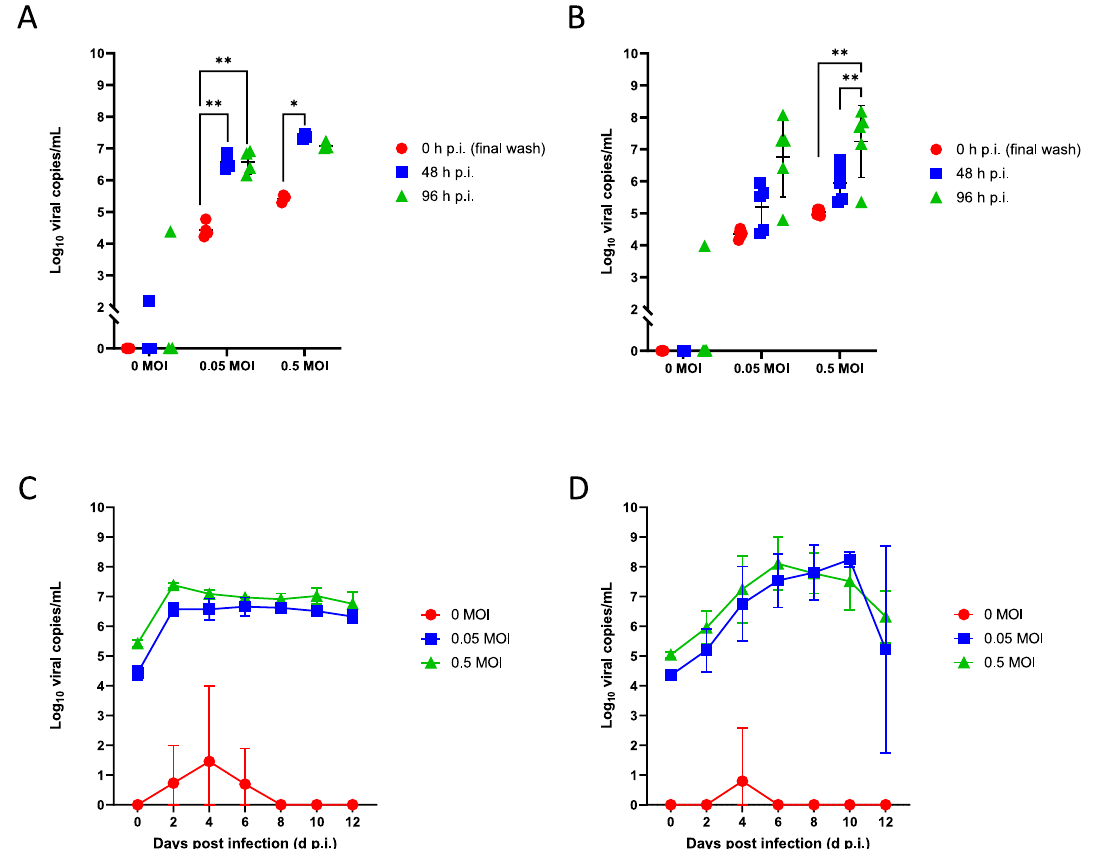
Figure 9. Infection of coronavirus strains in PREDICT96-ALI model. RT-qPCR analyses for viral copies of HCoV-NL63 ( A , C ) and HCoV-OC43 ( B , D ) in the apical wash of PREDICT96-ALI airway tissue model from a single donor, measured over 12 days across three different MOIs (0, 0.05, 0.5). ( A ) PREDICT96-ALI airway tissue inoculated with HCoV-NL63 and monitored for an increase in viral load at 48 h intervals with a statistically significant increase in viral copies at 48 and 96 h p.i. compared to 0 h p.i. for the MOI 0.05 condition, as well as a statistically significant increase at 48 h p.i. compared to 0 h p.i. for the MOI 0.5 condition. ( B ) PREDICT96-ALI airway tissue inoculated with HCoV-OC43 and monitored for an increase in viral load at 48 h intervals with a statistically significant increase in viral copies at 48 and 96 h p.i. compared to 0 h p.i. for the MOI 0.5 condition. Statistical significance: *p ≤ 0.05 and **p ≤ 0.01. N = 4–5 tissue replicates per donor, time-point and condition. Replicates that did not meet the minimum signal intensity after 45 PCR cycles are displayed along the x-axis. Viral copy number versus day post-infection shown for HCoV-NL63 ( C ) and HCoV-OC43 ( D ) shown for each MOI as indicated in the legends. Transient, non-productive viral infection detected as early as 48 h p.i. and as late as 144 h p.i. in mock condition (0 MOI), is likely the result of technical handling by the experimental